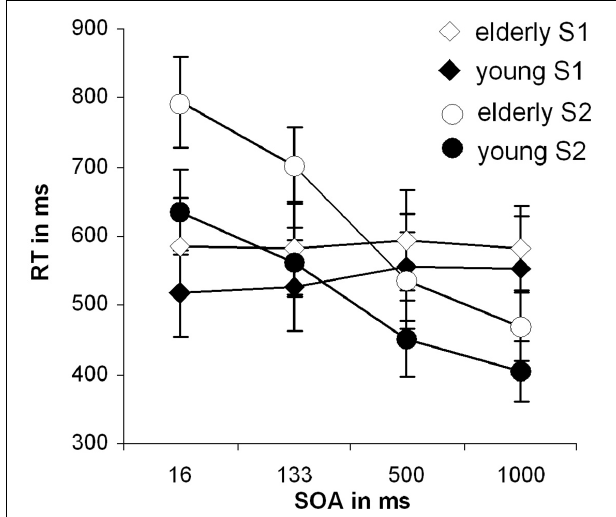
FIGURE 1 | Behavioral data of the dual-task performance: Mean reaction times with standard deviation of the second stimuli over the different SOA conditions for both groups separately; RT, reaction time; SOA, Stimulus onset asynchrony.